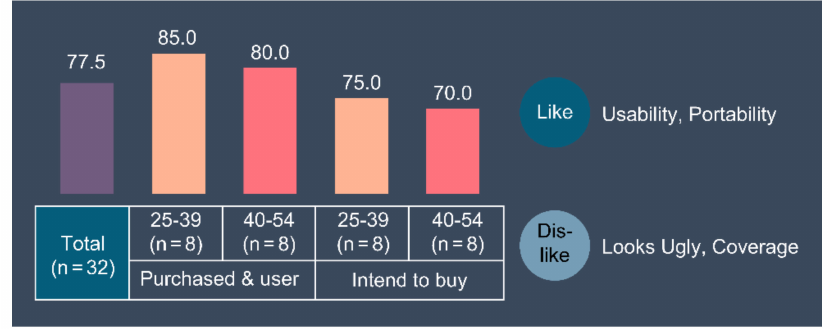
Figure 9. Consumer evaluation of a foldable LED-mask concept.